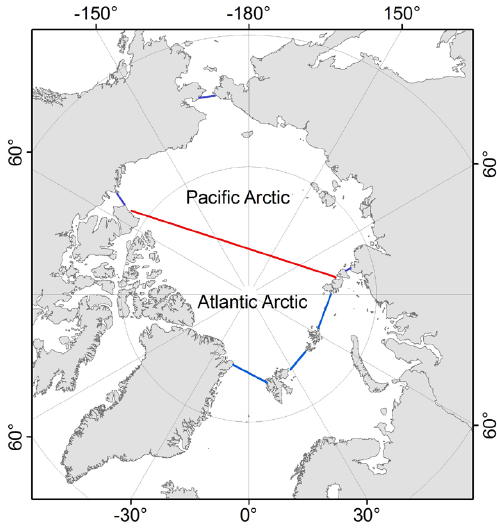
Figure 1. The fluxgate (red line) that is used to estimate sea ice area flux. The blue lines represent the boundaries of the PA and AA regimes. The endpoints in the North American and the Eurasian sides are (125.1 ◦ W, 73.0 ◦ N) and (101.0 ◦ E, 79.6 ◦ N),